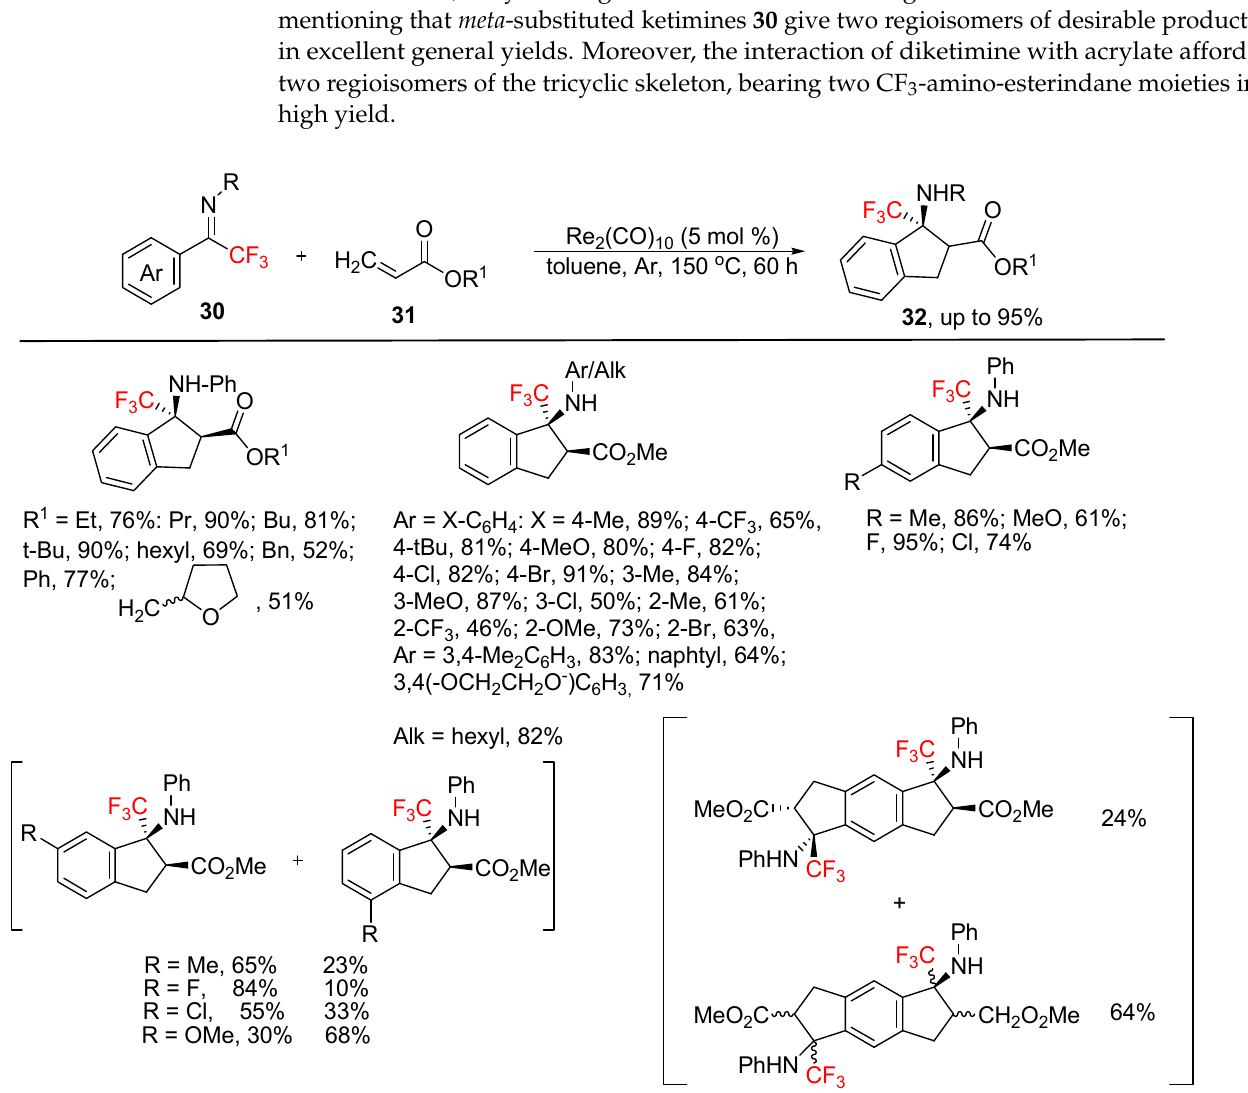
Scheme 21. Synthesis of CF 3 -aminoindanes 32 by Re-catalyzed [3+2] annulation of CF 3 -ketimines 30 with alkyl acrylates 31 .